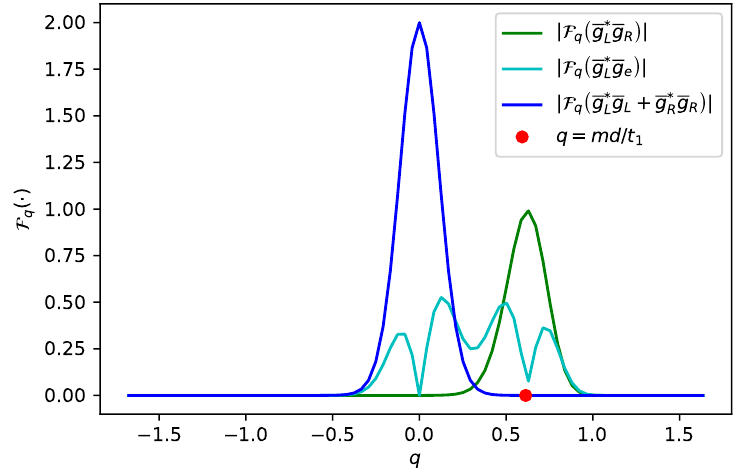
Figure 2: Fourier transformed products of single-particle wave functions after time- ( y , t ) occurring in Eq. (31), for the parameters given below Eq. 3 with of-flight g 1 L , R ∗ ( y , t ) g ( y , t ) (green) shows a peak around q = md / t I = 0.5. The cross term g 1 1 R L ∗ ( y , t ) g ( y , t ) (cyan) becomes small there. The same can be said whereas g 1 1 e L